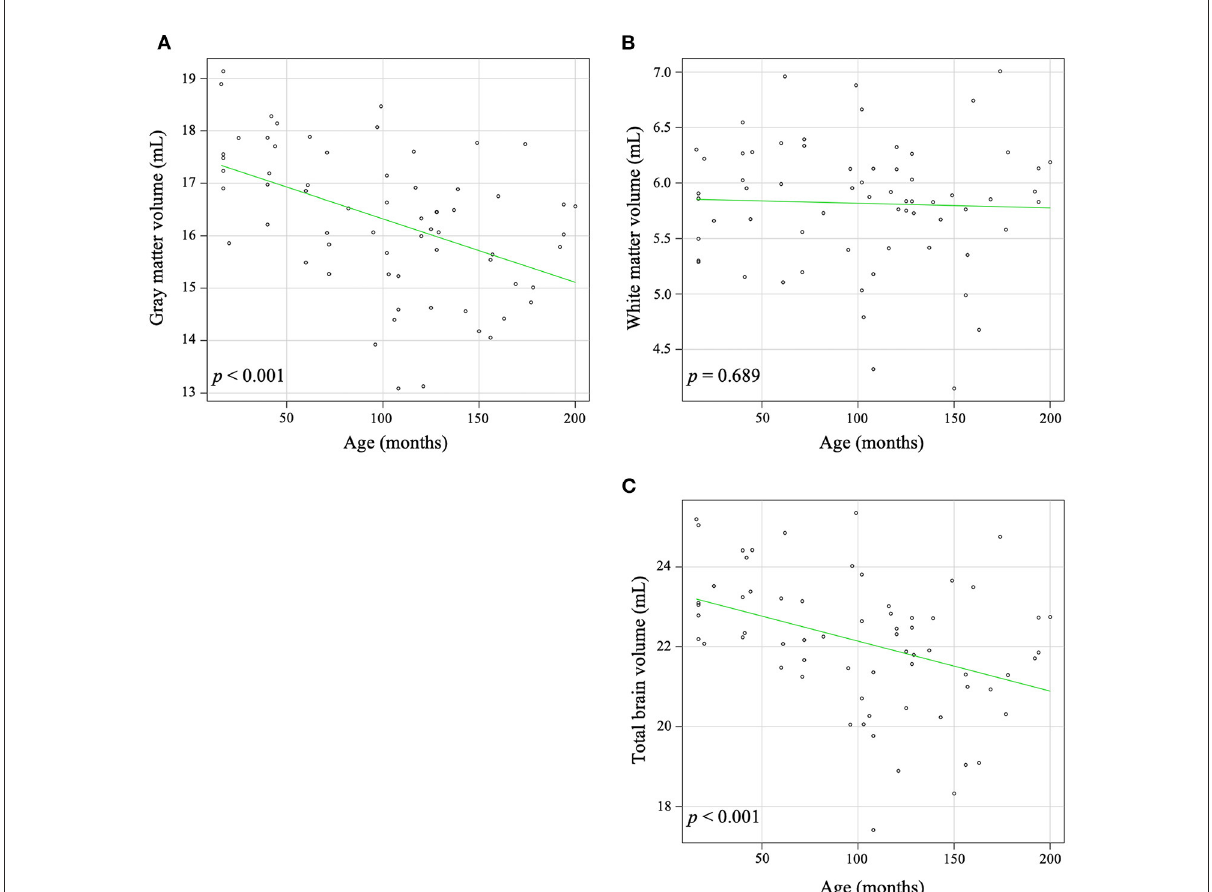
FIGURE2 Correlation between age and volume in gray matter (A) , white matter (B) , and total brain (C) . Increasing age was significantly associated with a decrease in gray matter ( r = − 0.491, p < 0.001) and the total brain volume ( r = − 0.416, p < 0.001). There is no significant correlation between aging and white matter volume ( r = − 0.050, p =